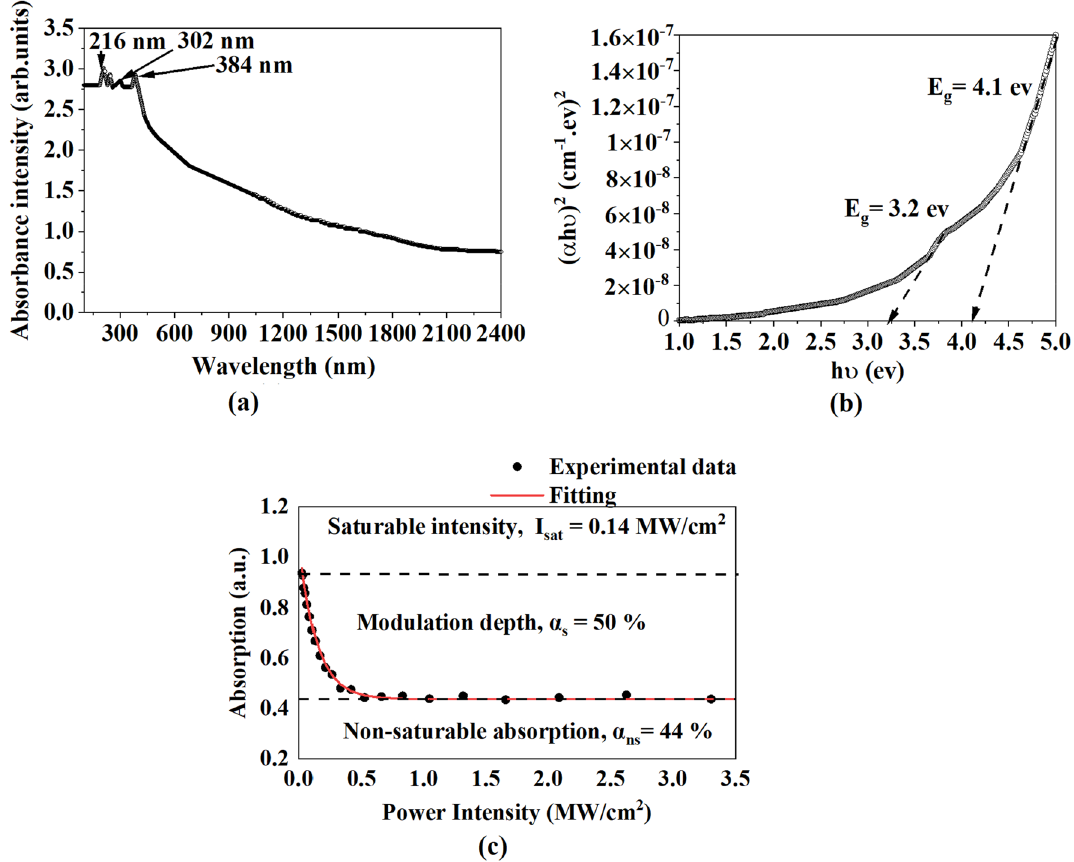
Figure 2. The characterization of SA film ( a ) The optical absorption spectrum ( b ) The optical band gap curve, and ( c ) The nonlinear absorption